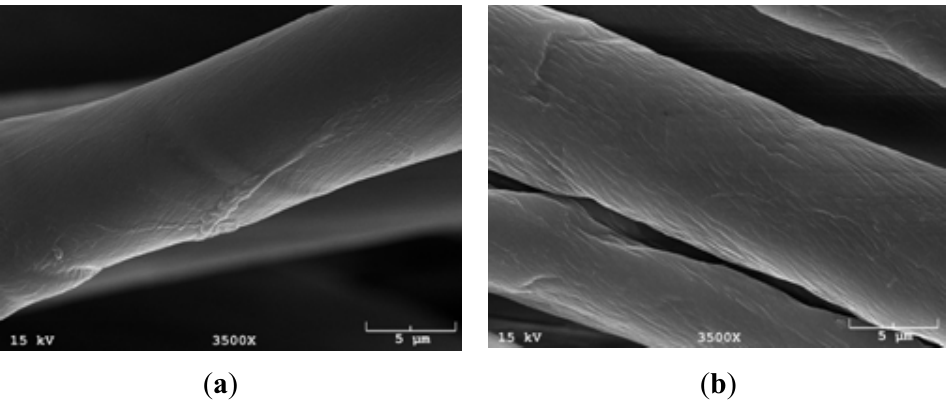
Figure 1. Untreated fibers of interlock knit cotton.